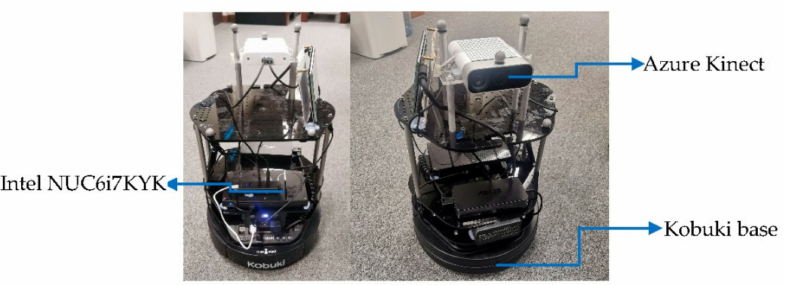
Figure 2. Front and back views of the TurtleBot2 with Kobuki base, Azure Kinect RGB-D sensor mounted on the top, and Intel NUC6i7KYK Mini